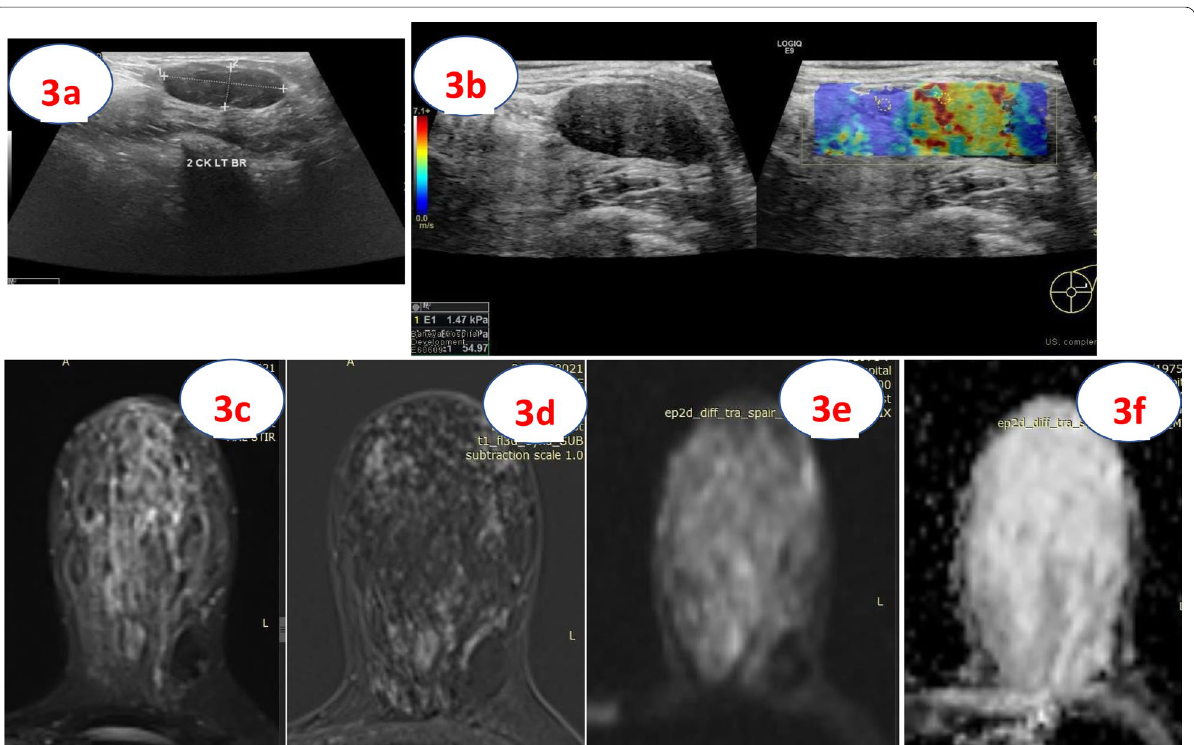
Fig. 3 A 44-year-old female presenting with a left breast lump. a US showed a left upper outer quadrant, well-circumscribed, ovel, hypoechoic mass lesion (BI-RADS 3). b SWE showed that the hard/red areas represent less than 50% of the lesion (score 2, considered as probably benign). The measures Emax 80.7 kPa and Eration 54.9 (considered as suspicious). c , d CE-MRI showed no contrast uptake within the lesion of concern (and = = consequently no kinematic curve). e , f DW-MRI showed non-restriction with and ADC value of